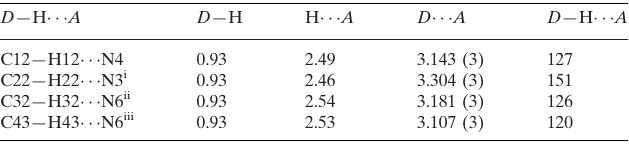
Hydrogen-bond geometry (A˚ , (cid:3)